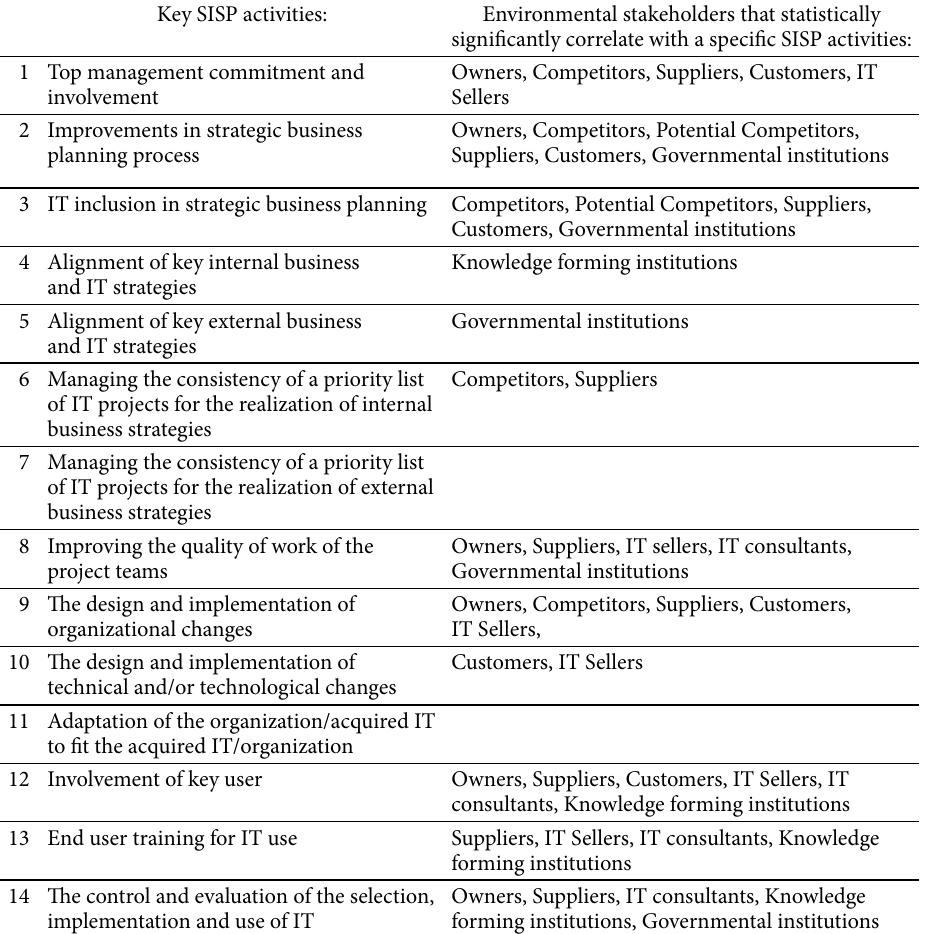
Table 4. Statistically significant correlations between individual environmental stakeholders and key SISP activities Key SISP